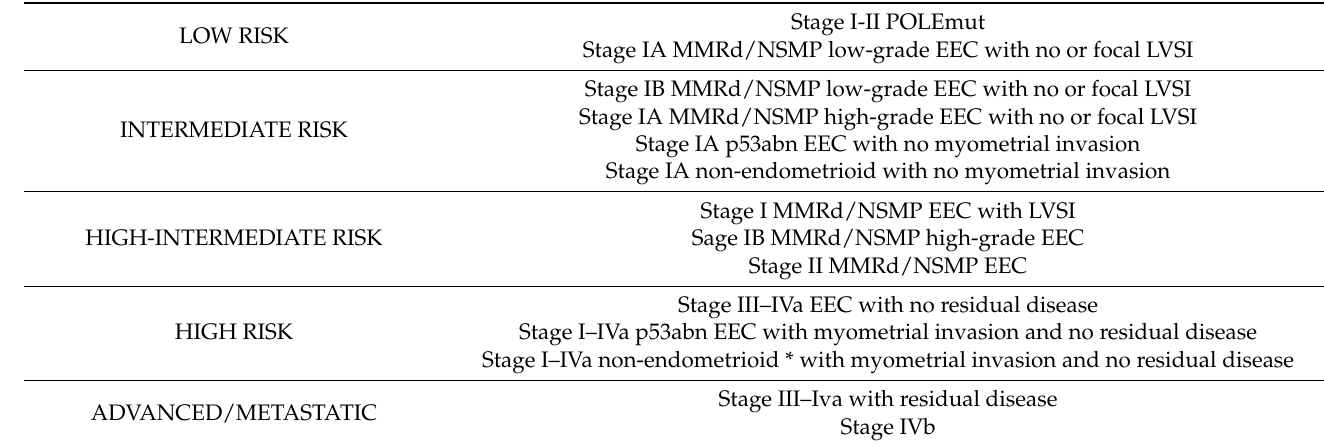
Table 1. Distribution of risk categories according to stage and